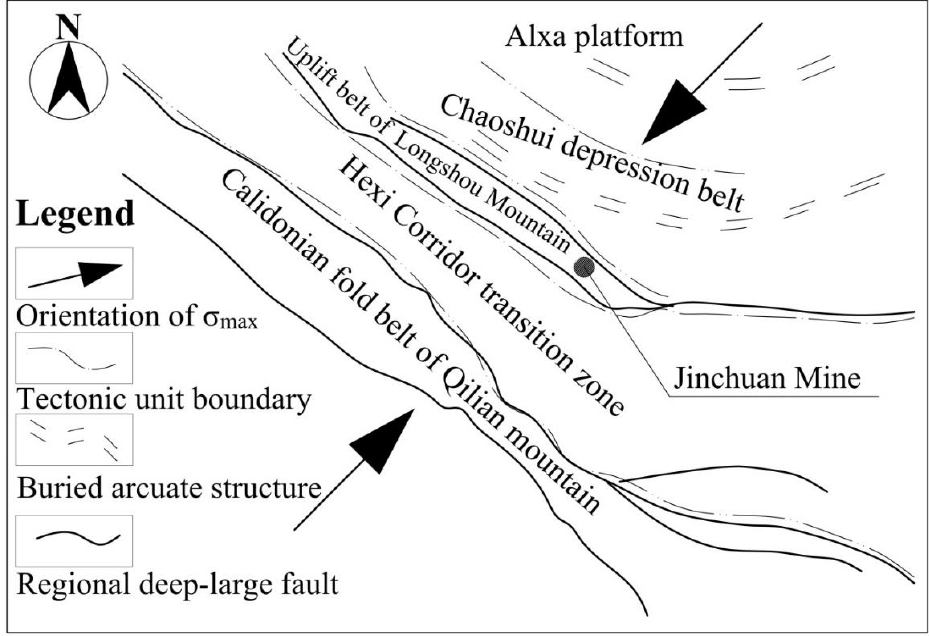
Figure 2. Tectonic map of Jinchuan.